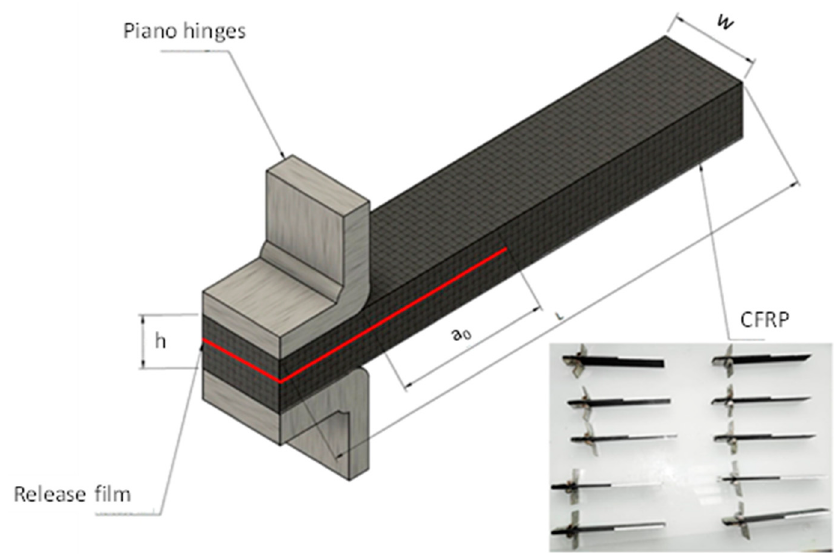
Figure 2. Schematic of the specimen for the Mode I test. L represents the length of the specimen, w the width, h the thickness and a 0 the initial 50 mm pre-crack. The inset photo shows specimens ready to be measured.